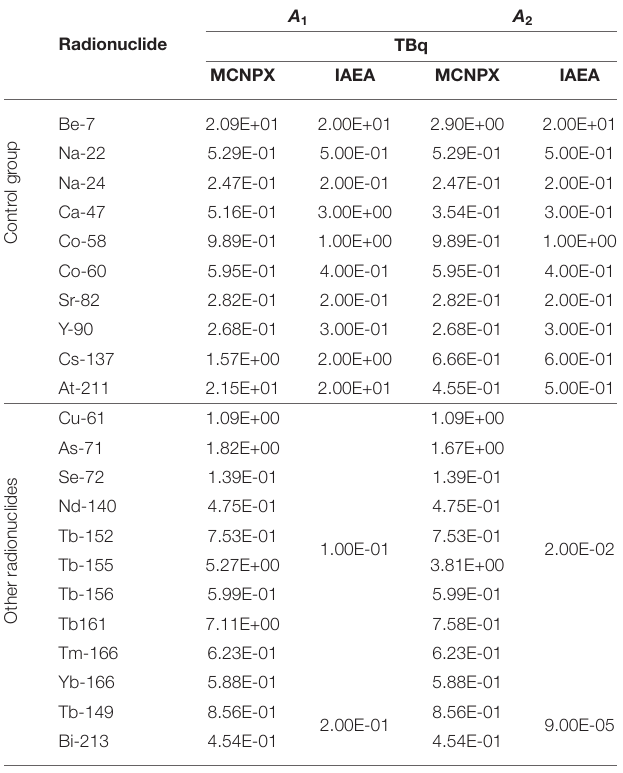
TABLE 5 | Results of the A 1 and A 2 values obtained with the MC method compared with the ones listed in the IAEA Safety guide (4).